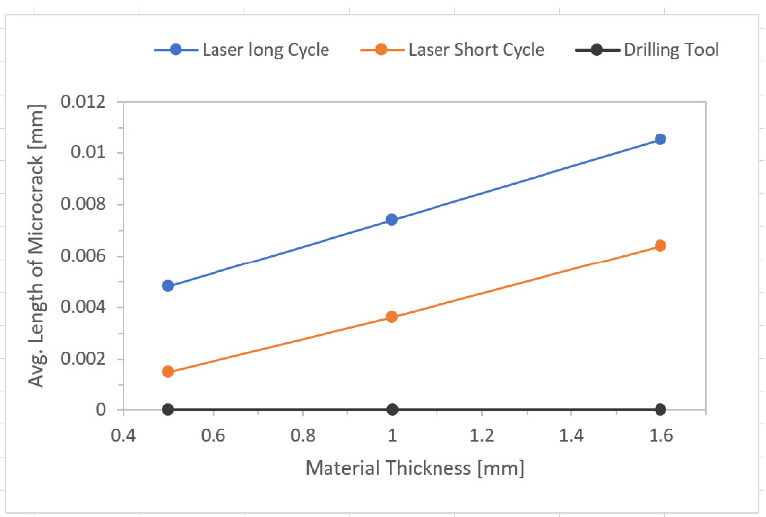
Figure 18. Effect of drilling methods on recast layer occurrence.